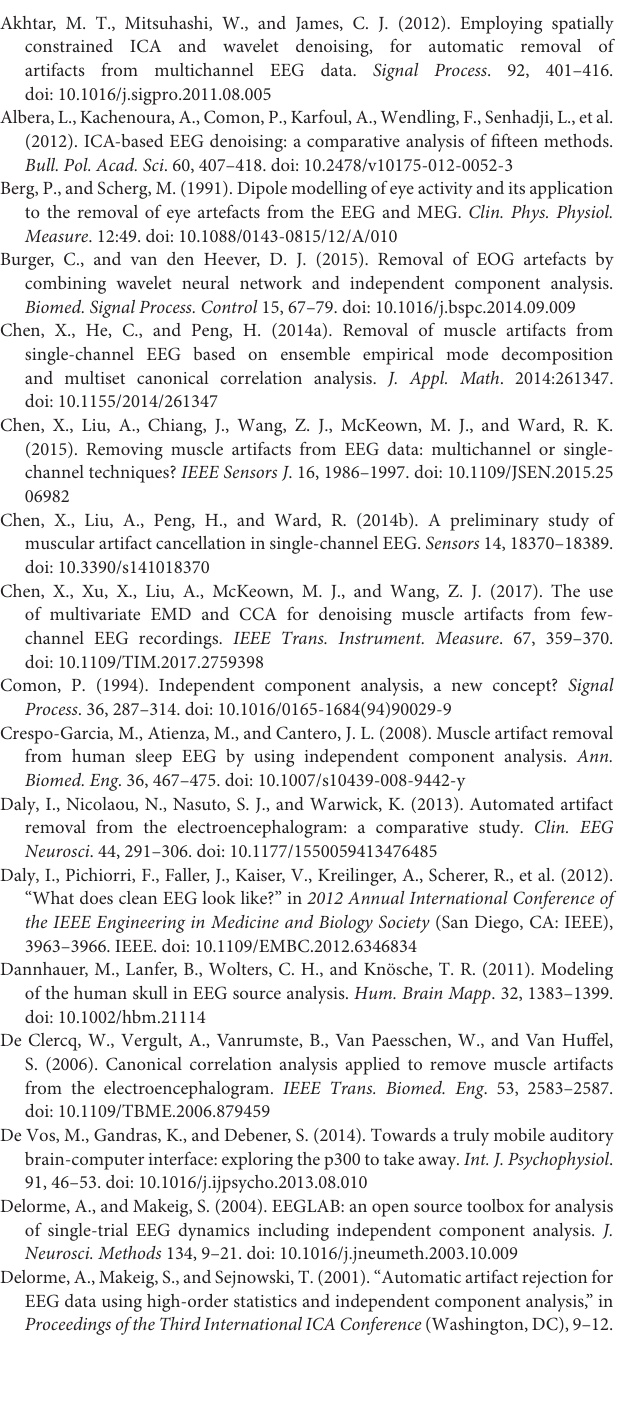
filtered with 40–100 Hz for one trial in different conditions ( Supplementary Figure 9 ), time series validation results by using simulated EEG with simulated EMG ( Supplementary Figure 10 ) and real EMG ( Supplementary Figure 11 ), and performance comparison between ERASE and conventional ICA by